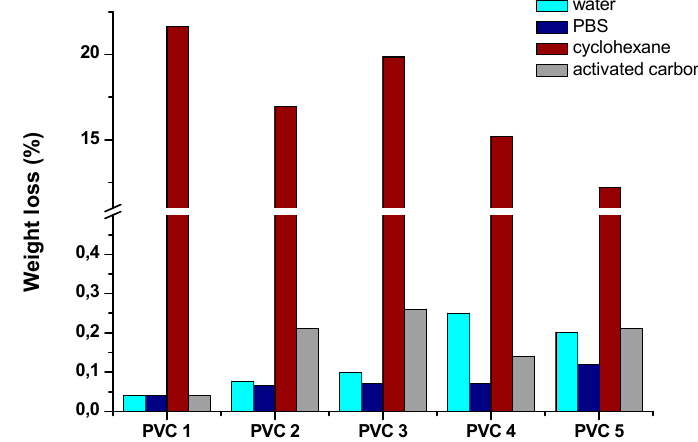
Figure 5. PVC blends weight loss percentage results determined from the leaching and volatile resistance tests. Error deviations were less than or equal to 0.01% (n = 3).